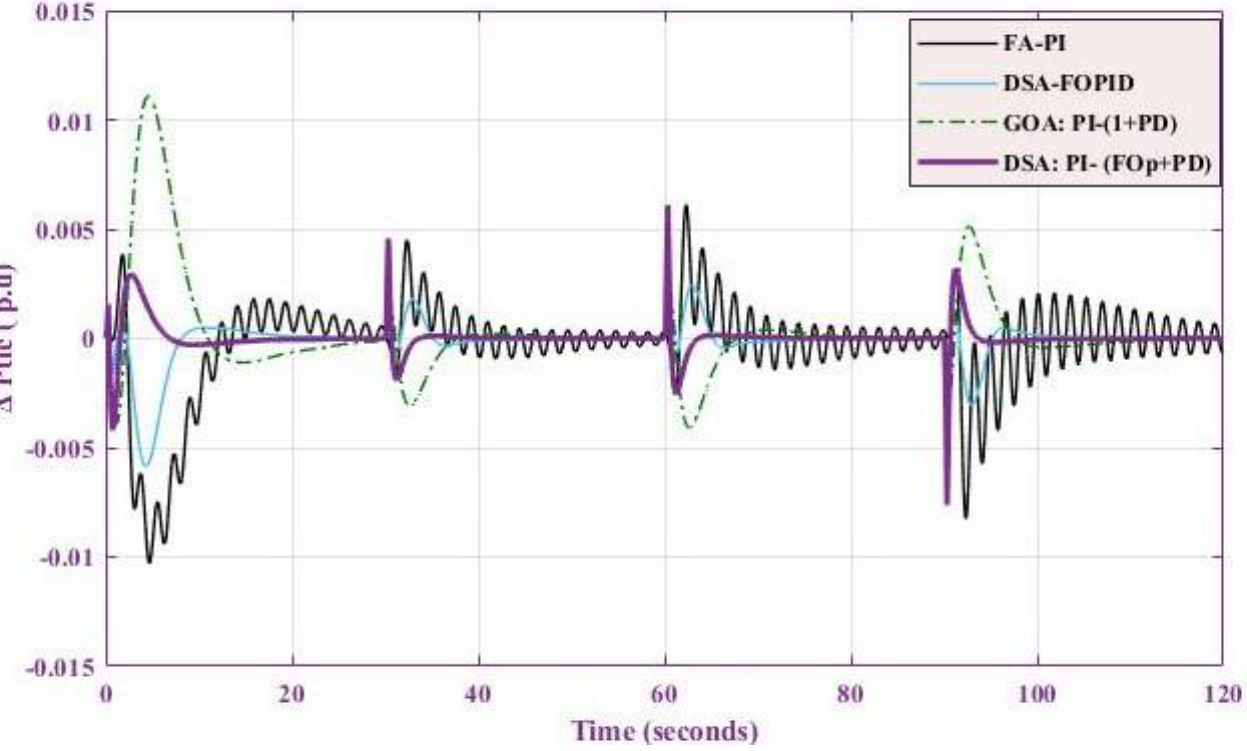
Table 4. Performance of controllers in Area-1 and Area-2 at 7% load change .